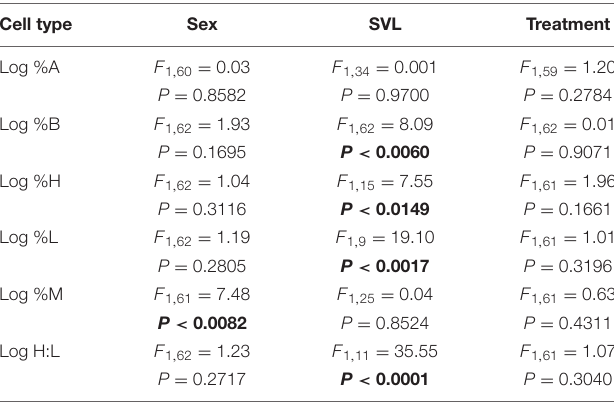
TABLE 2 | Effects of mixed model analyses on the factors affecting white blood cell counts of hatchling keelback snakes ( Tropidonophis mairii ) in Experiment #1. Cell type